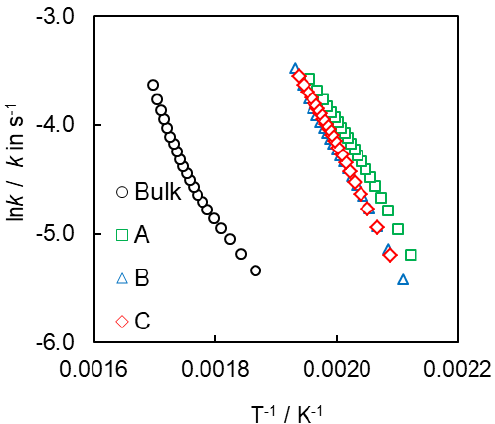
Figure 9. Arrhenius plots for polymerization of bulk and confined cyanate ester.